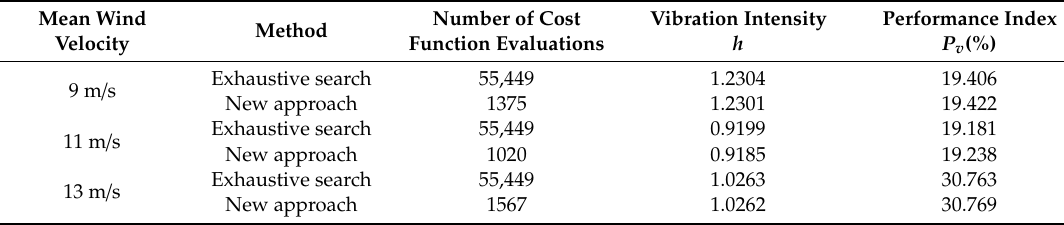
Table 3. Comparison between the exhaustive method and the proposed approach for various wind conditions.